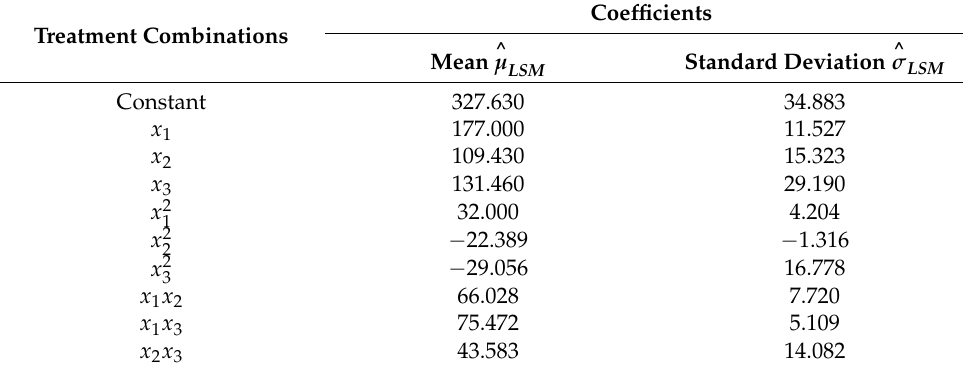
Table 1. Coefficients of the estimated response functions using LSM.